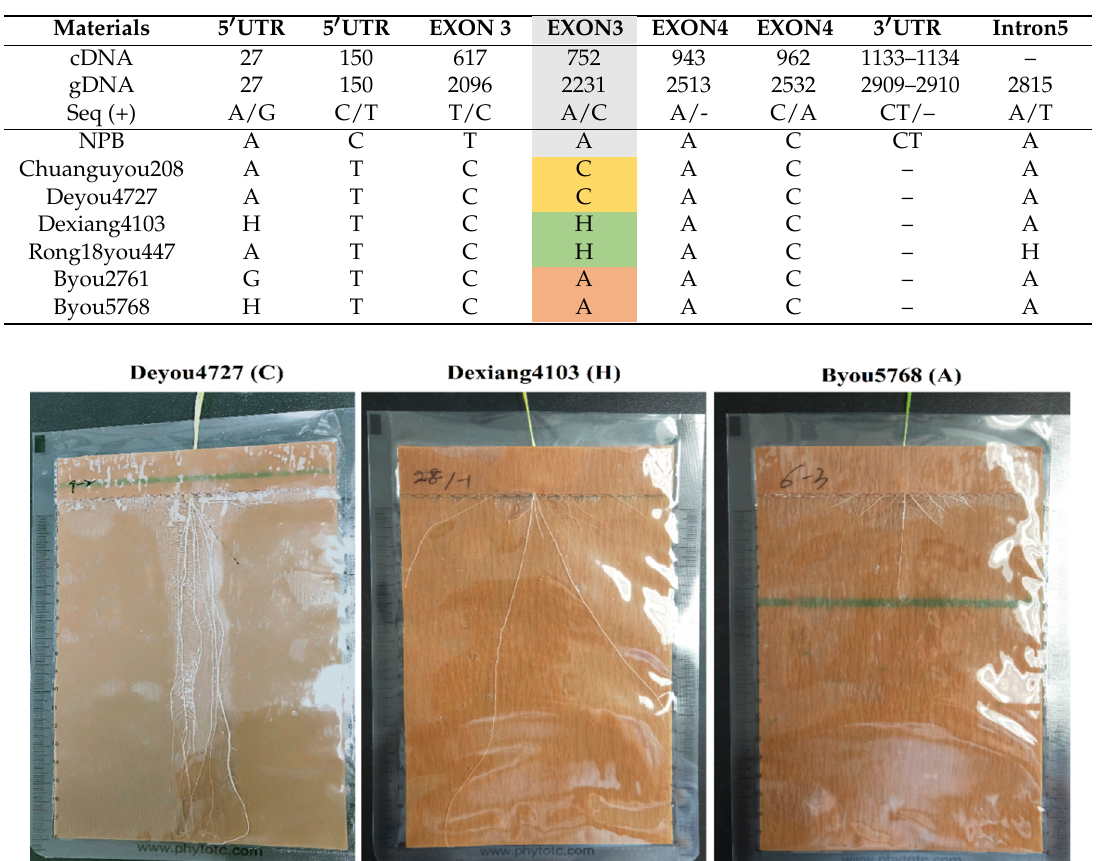
Table 3. Effect of drought stress on antioxidant enzyme activity in rice varieties. SOD, Superoxide dismutase; CAT, Catalase; POD, Peroxidase.